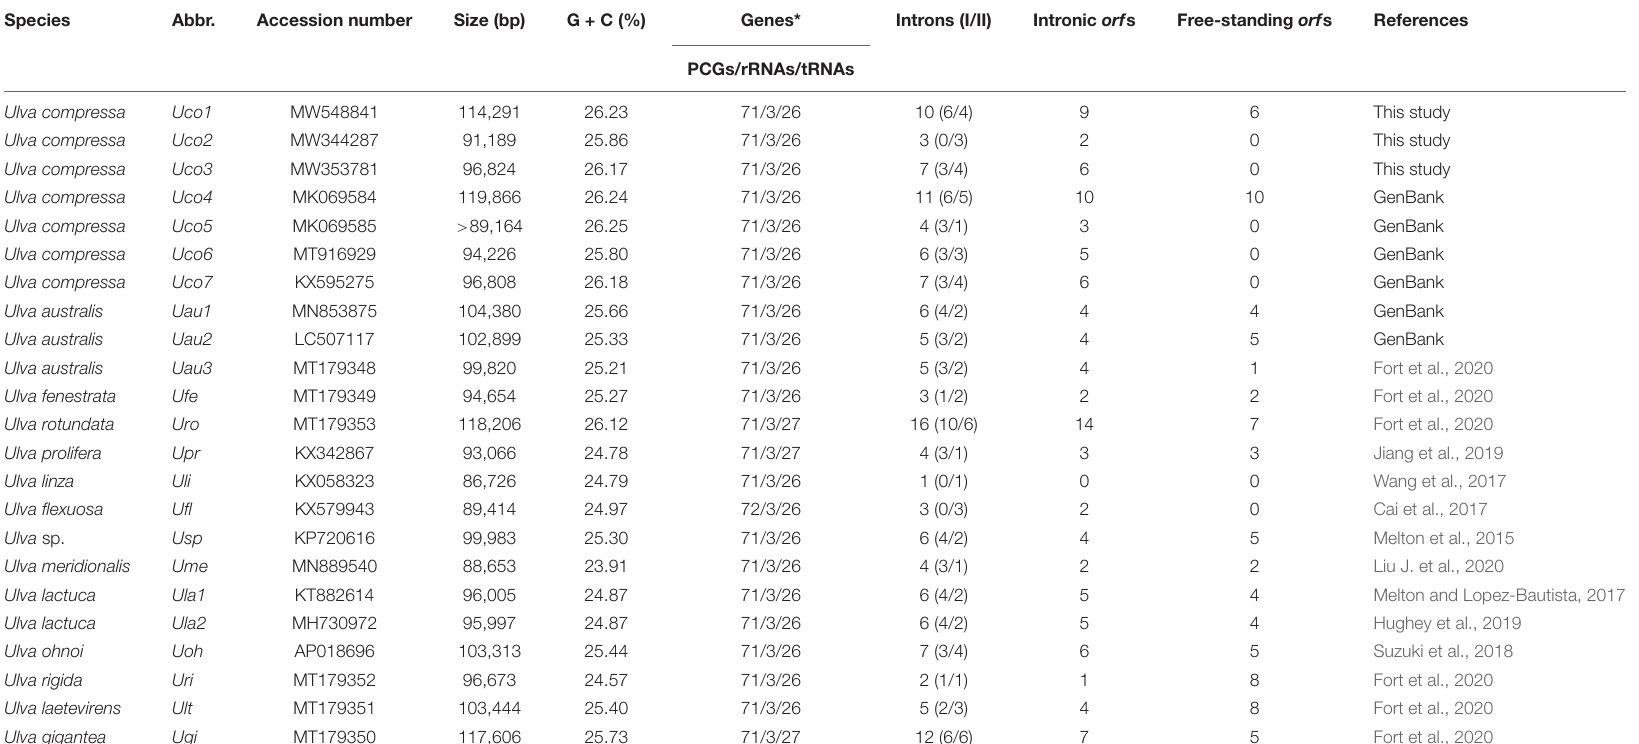
TABLE 1 | Comparison of genome features in the 23 Ulva chloroplast